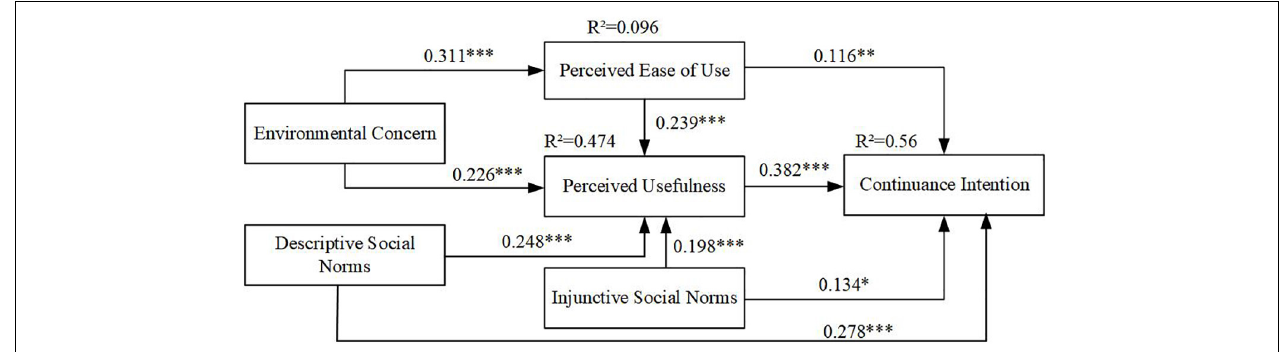
FIGURE 2 | The results of the proposed model. *** p < 0.001, ** p < 0.01, * p <